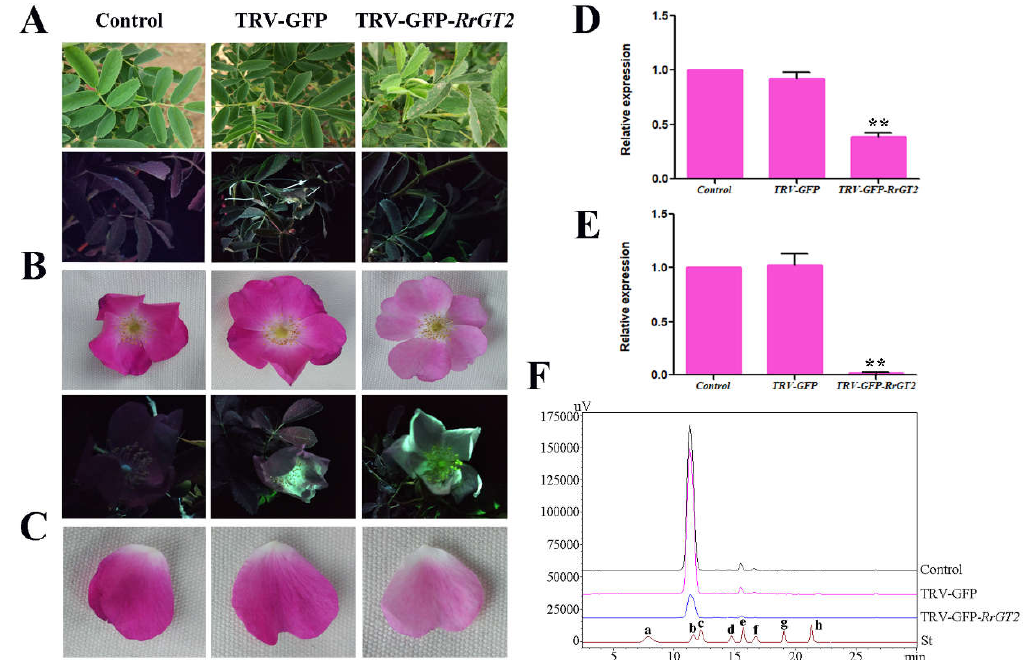
Figure 5. Validation of VIGS in R. davurica . Comparisons between the control group and VIGS-treated groups (TRV-GFP and TRV-GFP- RrGT2 ) with respect to leaves ( A ) and flowers at the full opening stage ( B ). The plants were imaged under normal light and ultraviolet illumination. ( C ) The color contrast of a single petal. qRT-PCR detection of leaves ( D ) and flowers at the full opening stage ( E ) in the control and VIGS-treated groups. RrGAPDH was used as an internal control. The error bars represent the SDs of triplicate reactions. The experiment was repeated three times and each yielded similar results. ** indicates a significant difference from the control at p < 0.01 according to Student’s t -test. ( F ) HPLC-derived chromatograms of flowers at the full opening stage. Eight kinds of anthocyanin standards (St) were used for detection: (a) Dp3G5G; (b) Cy3G5G; (c) Dp3G; (d) Pg3G5G; (e) Cy3G; (f) Pn3G5G; (g) Pg3G; and (h) Pn3G.